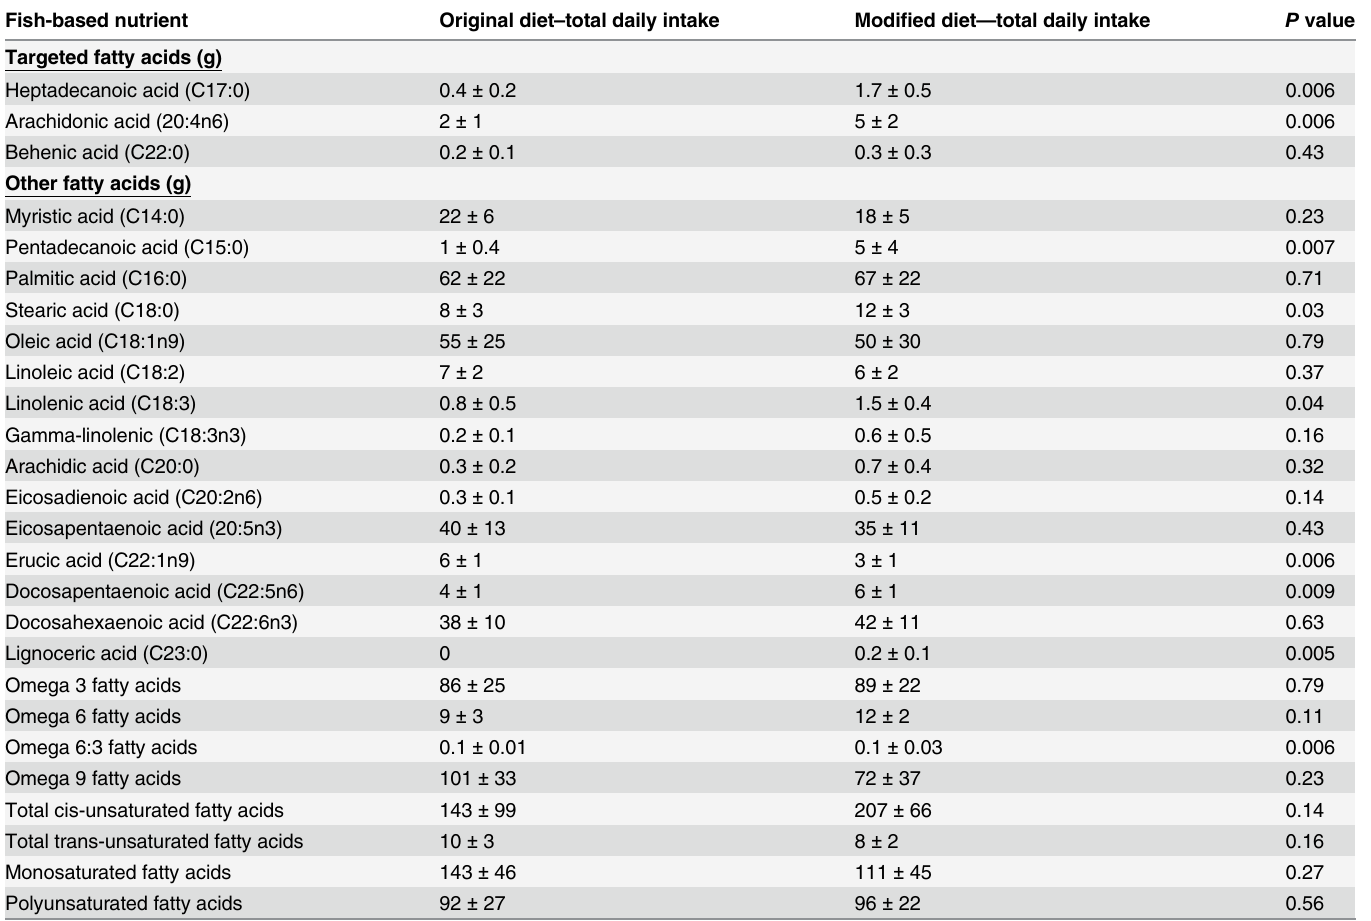
Table 2. Comparisons of dietary fatty acid (g) intake between original and modified diets for six bottlenose